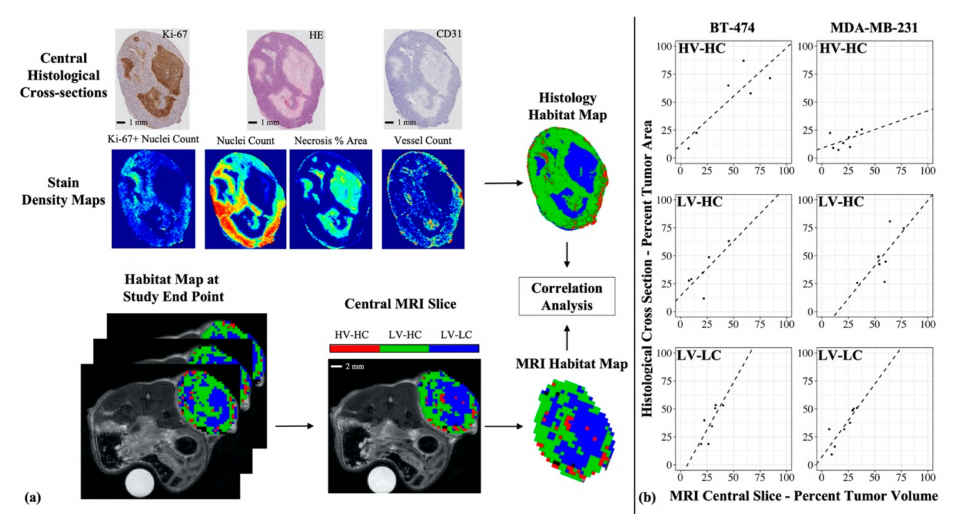
Figure 5. Correlation of MRI-derived tumor habitats with histological habitats. Stain density maps were used to generate histological habitat maps. The percent tumor area of each habitat was calculated for each histological section (panel ( a )). Central imaging slices were selected from study endpoint (day 4 for BT-474 cohort, day 3 for MDA-MB-231 cohort) MRI data (panel ( a )) and percent tumor volume of each habitat was calculated for each tumor’s central slice. The correlation was calculated between percent tumor volume (MRI) and percent tumor area (histology) for each habitat. For the BT-474 cohort (panel ( b ), left column), percent tumor volume of MRI-derived habitats showed a significant positive correlation with percent tumor area of histology-derived habitats for the HV-HC ( r 2 = 0.74, p = 0.03) and LV-LC ( r 2 = 0.70, p = 0.04) habitats. For the MDA-MB-231 cohort (panel ( b ), right column), percent tumor volume of MRI-derived habitats showed a significant positive correlation with percent tumor area of histology-derived habitats for the LV-HC ( r 2 = 0.70, p = 0.04) and LV-LC habitats ( r 2 = 0.73, p <